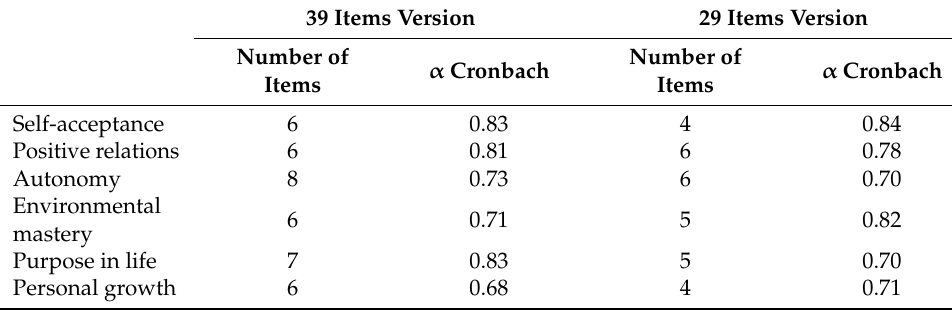
Table 1. Psychometric properties of the Psychological Well-being scale. Spanish version.